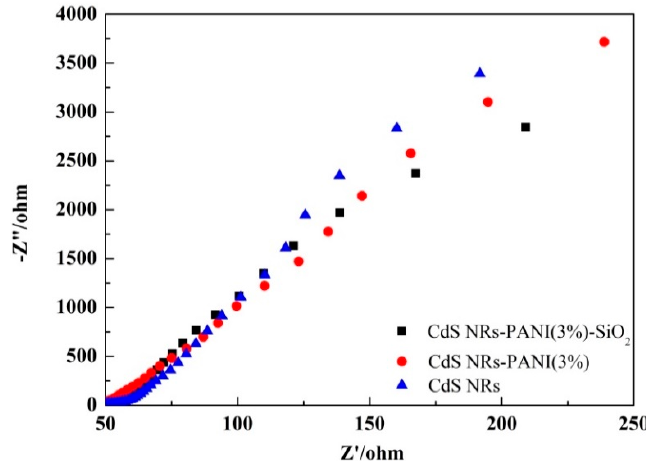
Figure 5. Electrochemical impedance spectra (EIS) plots of CdSNRs, CdS NRs-PANI (3%), and CdS NRs-PANI (3%)-SiO 2 (20%).